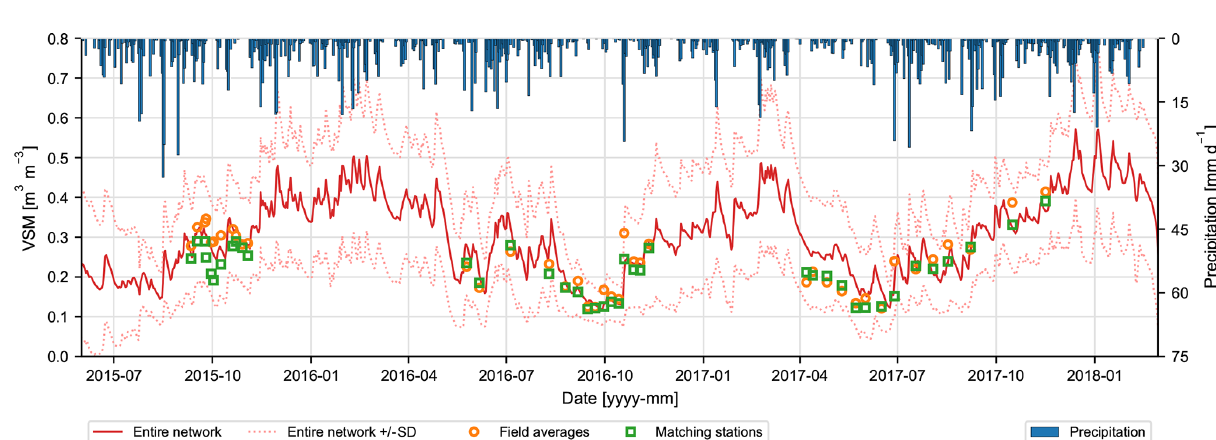
Figure 8. Mean values of field-averaged surface soil moisture measured during the 2015, 2016, and 2017 field campaigns (marker: circle) and of 5cm VSM measured at the matching monitoring stations (marker: square). The solid and dotted lines represent the mean 5cm VSM of the entire network ± the standard deviation. The precipitation shown on the secondary axis is derived as the arithmetic mean from the data collected by the three KNMI